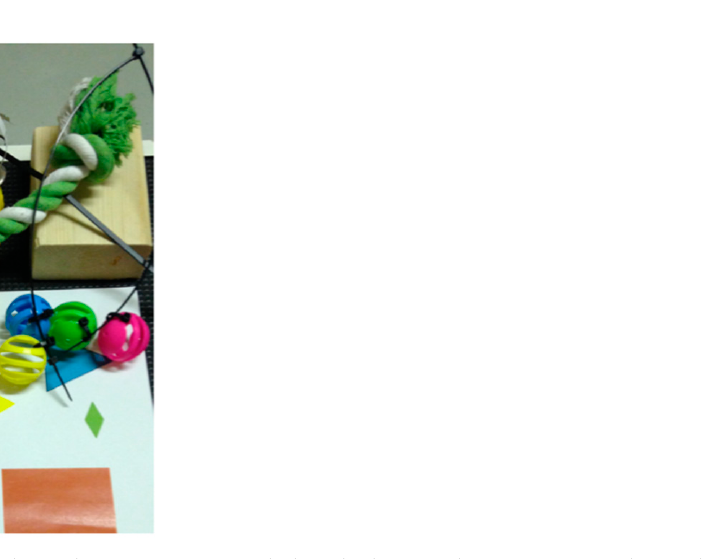
Figure 1. Environmental enrichment items provided to chickens in the environmental complexity with physical items (P) treatment group.